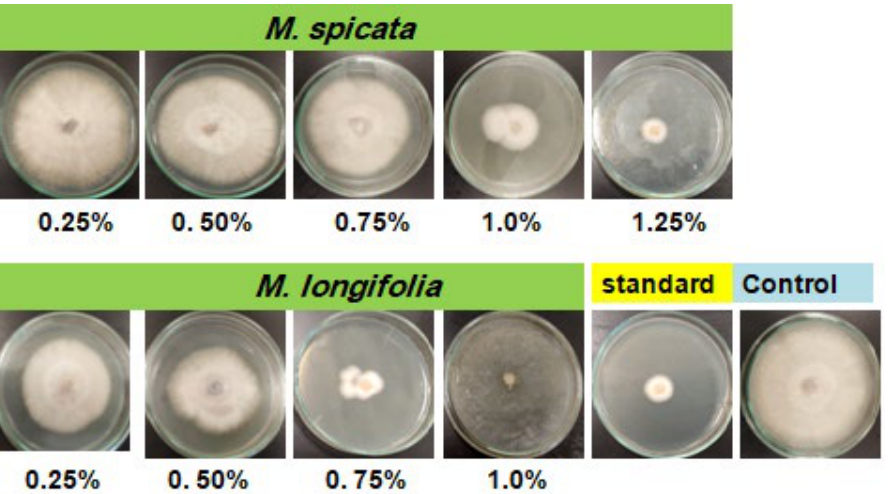
Figure 1. Effects of the two studied EOs at different concentrations on mycelial growth reduction percentages of F. oxysporum after 7 days of incubation at 28 ± 2 °C.